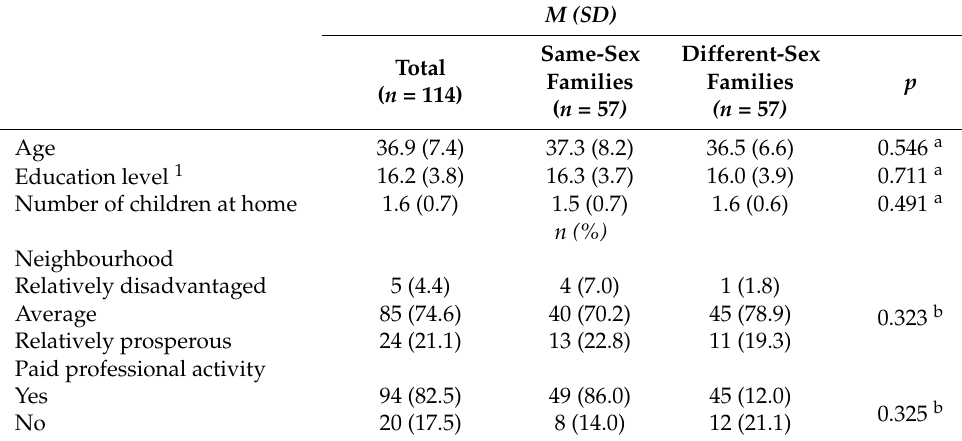
Table 1. Sociodemographic Variables as a Function of Family Type (Study